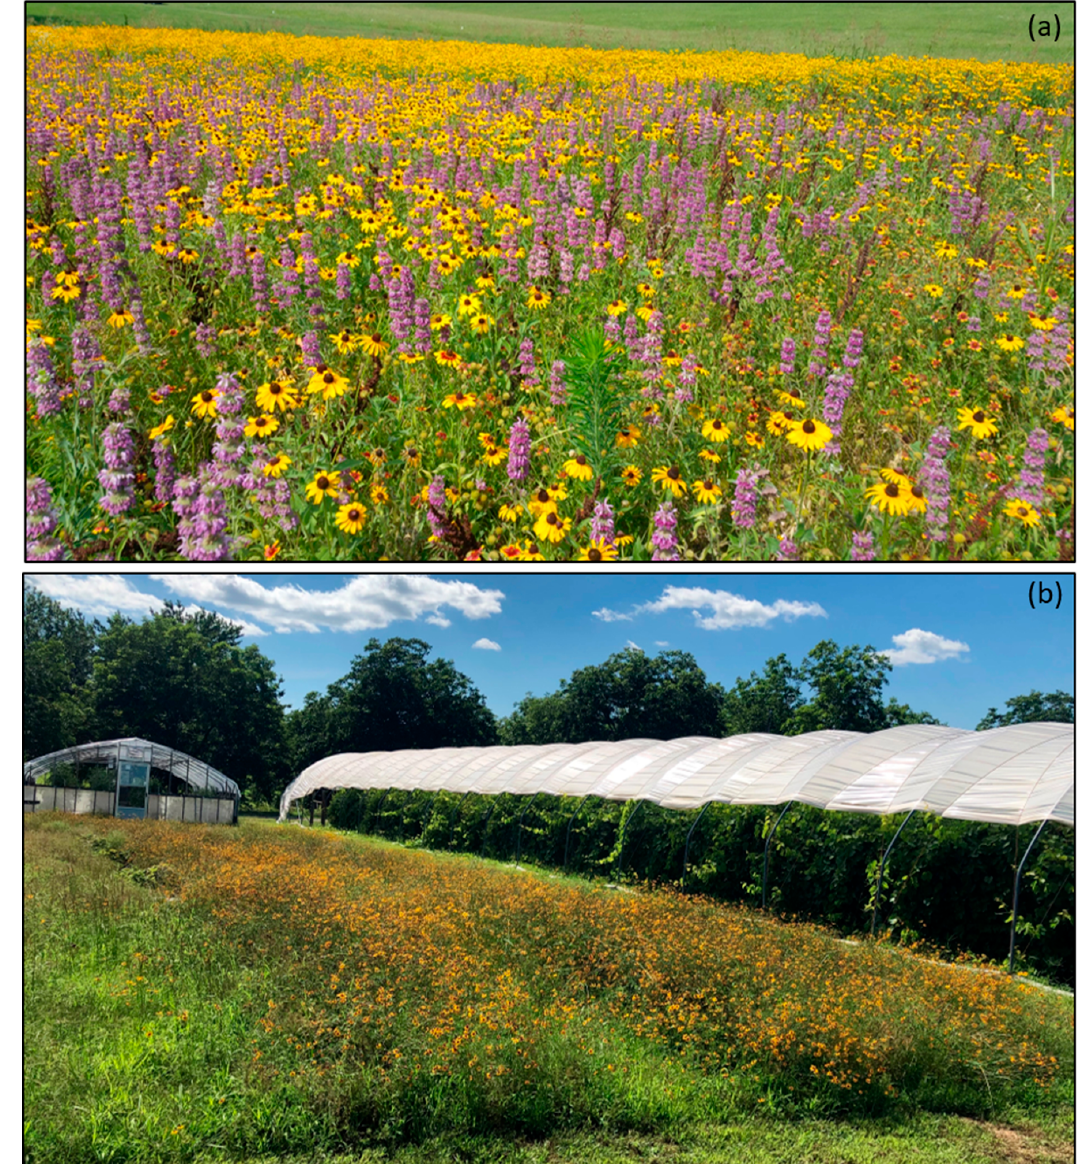
Figure 2. Establishment of floral resource plantings comprised of diverse native flowering plants for bees and other pollinators near crop fields ( a ) and high tunnels ( b ). Pictures by N. Joshi.